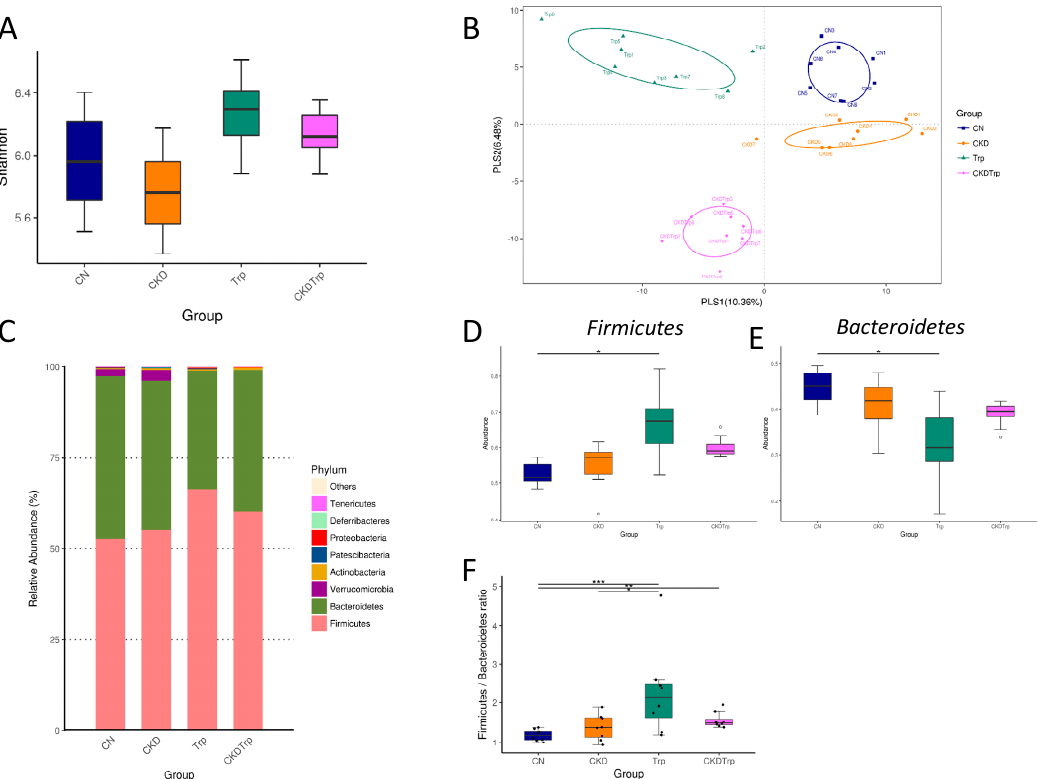
Figure 4. Effects of maternal adenine-induced chronic kidney disease (CKD) and tryptophan supplementation (Trp) on the gut microbiota in offspring at 12 weeks of age. ( A ) Variation in fecal bacterial α -diversity represented by the Shannon’s diversity indexes. ( B ) β -diversity changes in gut microbiota across groups by the Partial Least Squares Discriminant Analysis (PLS-DA). ( C ) Relative abundance of top 10 phyla of the gut microbiota among the four groups. ( D ) Relative abundances of the phylum Firmicutes . ( E ) Relative abundances of the phylum Bacteroidetes . ( F ) The Firmicutes to Bacteroidetes ratio. * p < 0.05. ** p < 0.01. *** p < 0.001.